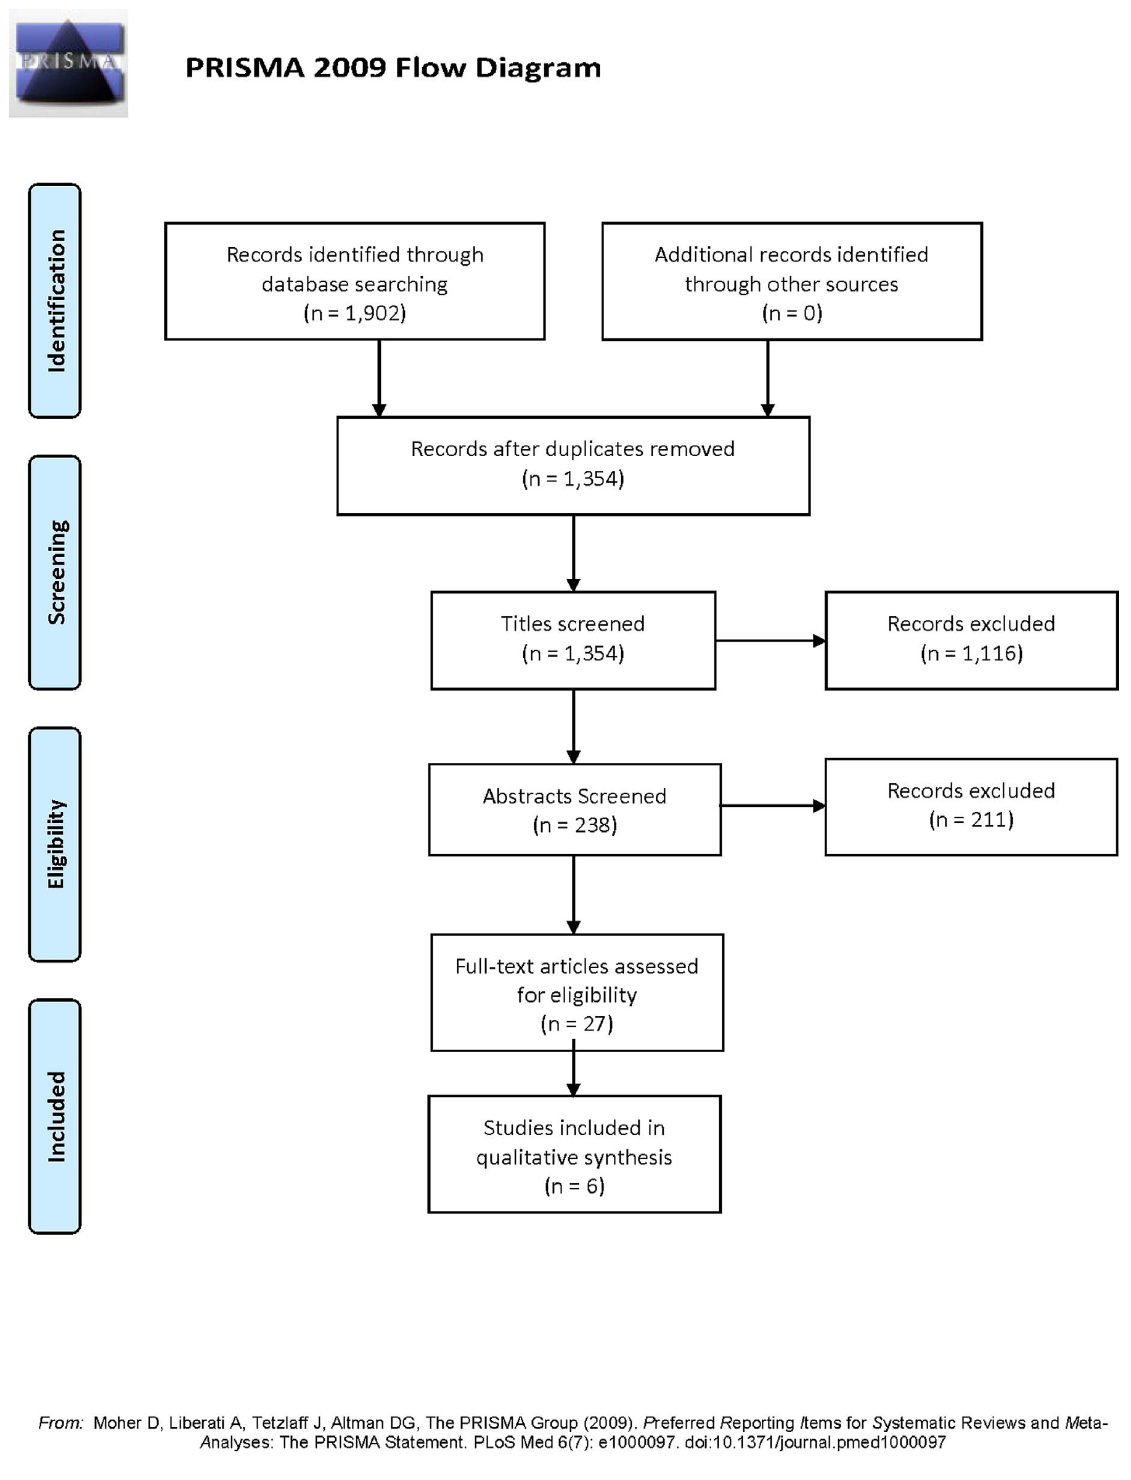
Figure 1. Preferred Reporting Items for Systematic Reviews and Meta-Analyses (PRISMA) fl ow diagram [42] illustrating the manuscript identi fi cation and screening